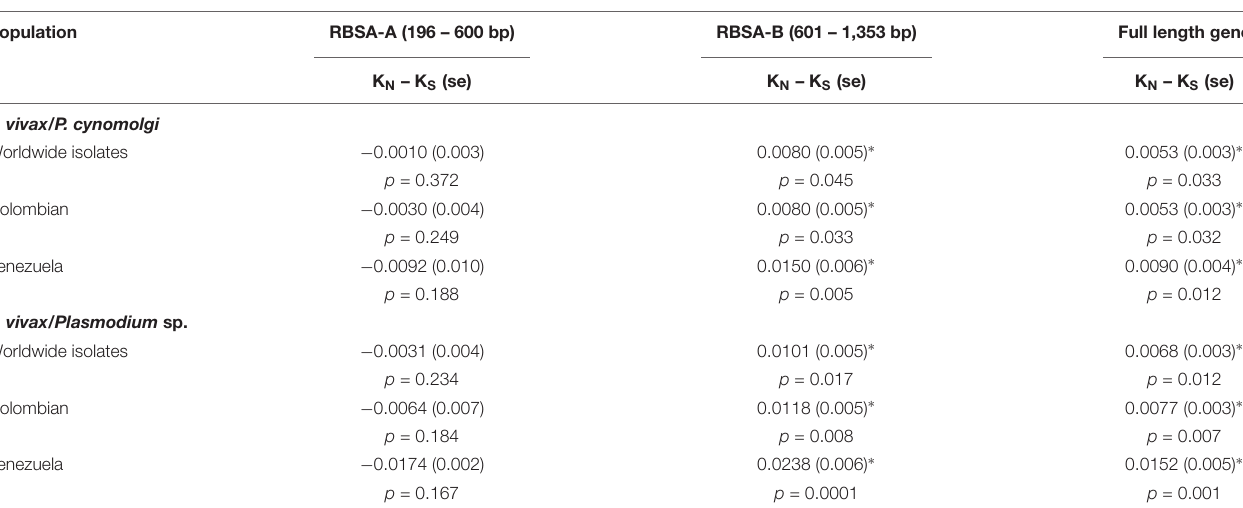
TABLE 4 | K N –K S difference between Plasmodium